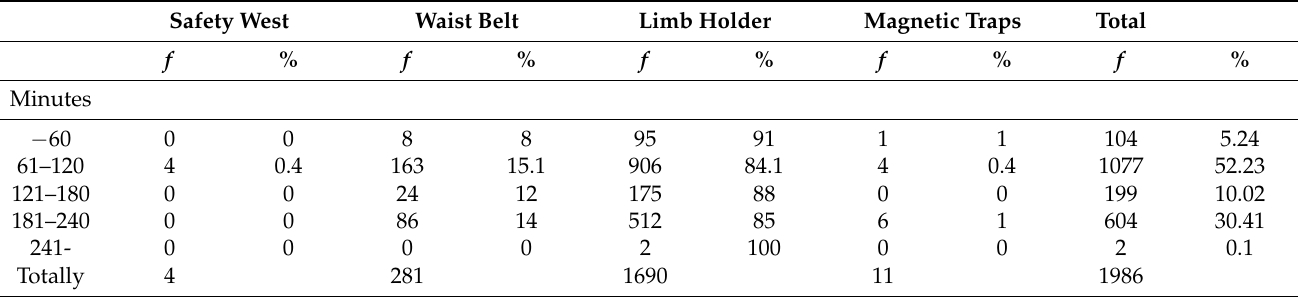
Table 3. The length of each physical restriction and restriction method used (N = 1798).